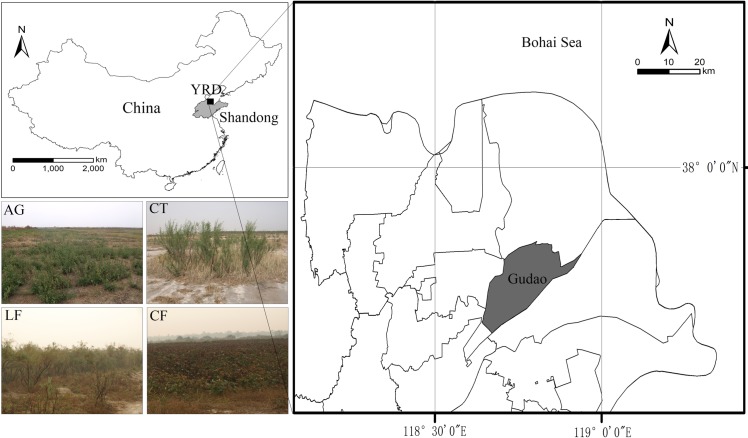
The study location and plant communities of the northeast estuarine area in the YRD, China.